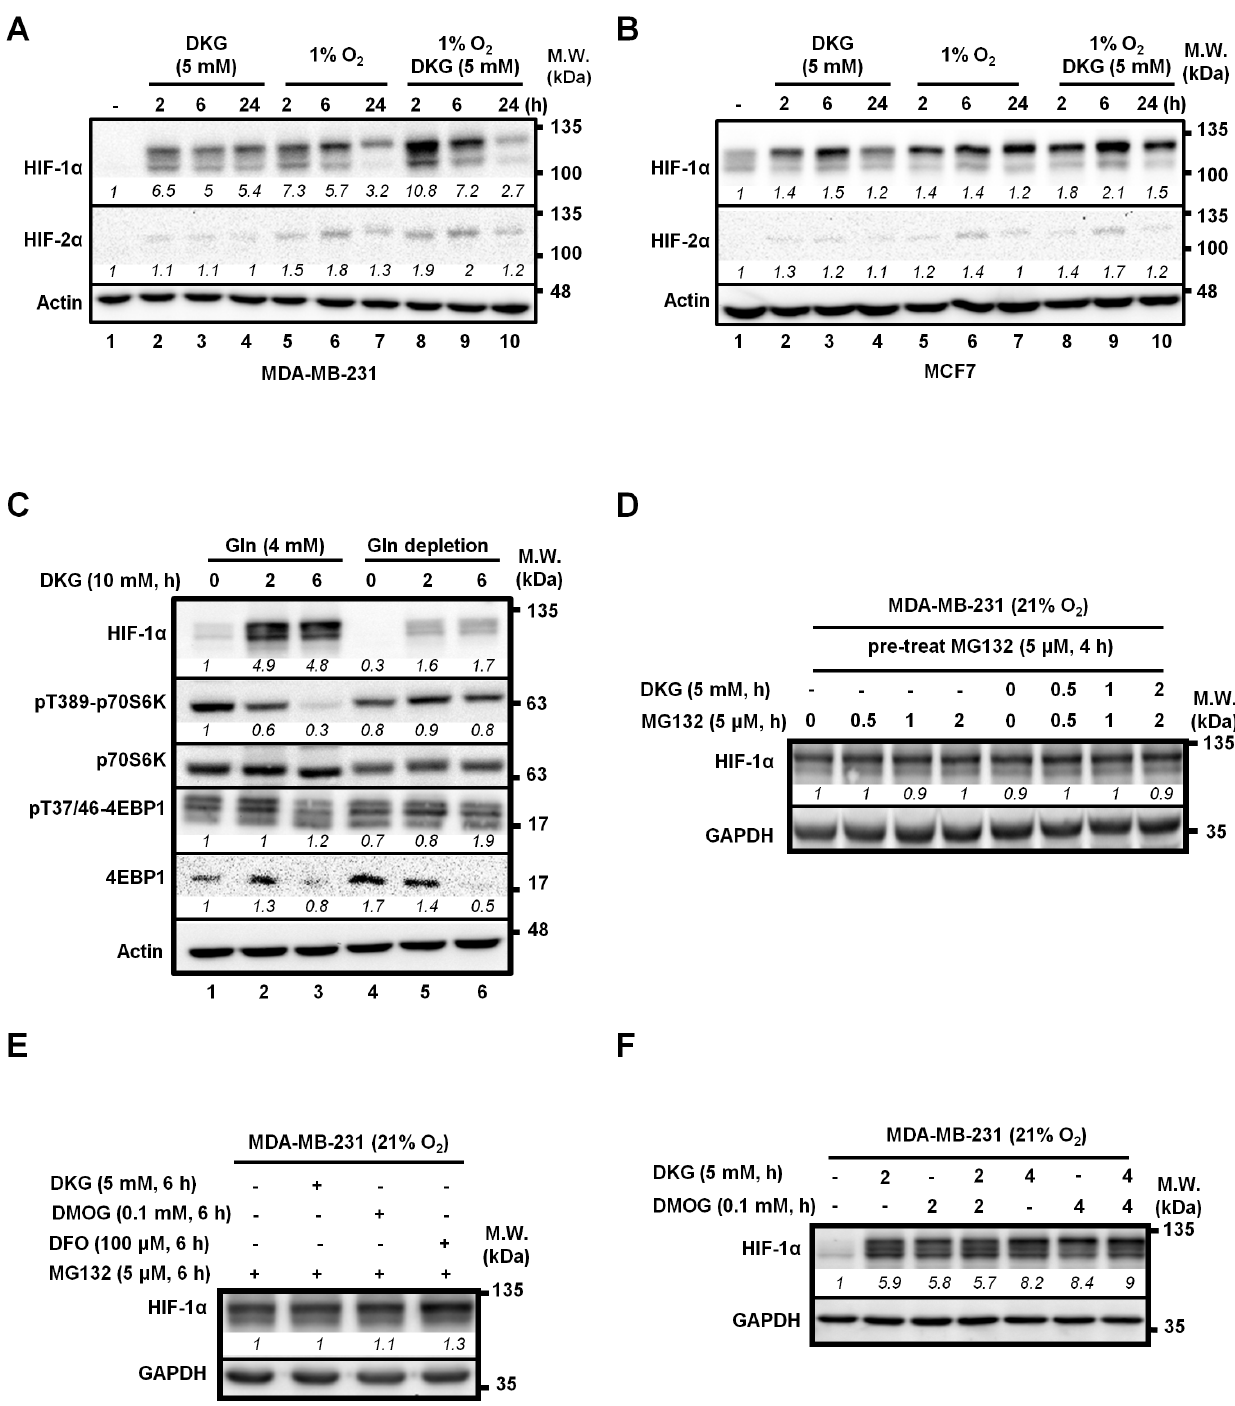
Figure 2. DKG blocks HIF-1 a degradation, rather than inducing its transcription or translation. ( A, B ) DKG increases HIF-1 a abundance in both normoxic and hypoxic conditions. MDA-MB-231 (A) and MCF7 (B) cells were cultured in normoxia (21% O 2 ) or hypoxia (1% O 2 ) for 2-, 6- or 24-hour in the presence or absence of DKG (5 mM). ( C ) DKG reduces mTOR signaling. MDA-MB-231 cells were treated with DKG in the presence or absence of Gln. The signals of pT389-p70S6K and pT37/46-4EBP1 were used to as surrogate markers for mTOR activation. ( D ) DKG fails to further elevate HIF-1 a protein abundance in cells pre-treated with MG132. MDA-MB-231 cells were pre-treated with a proteasome inhibitor, MG132 (5 m M, 4-hour) to block the proteasomal degradation. The cells were then continuously treated with MG132 and vehicle or DKG to assess HIF-1 a abundance. ( E ) DKG, like DMOG or